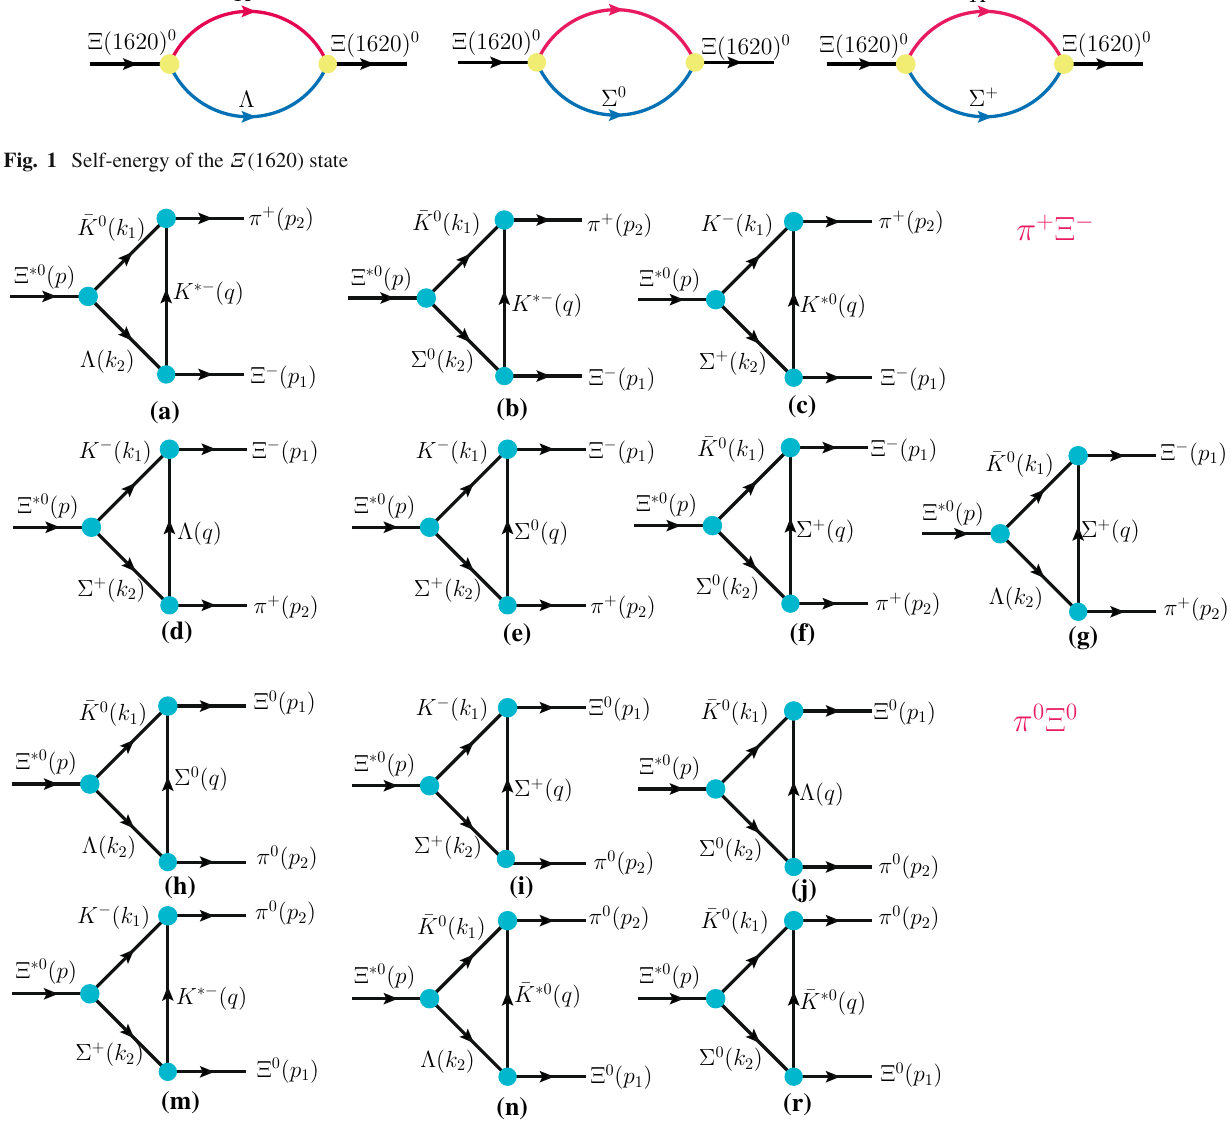
Fig. 2 Feynman diagrams for the Ξ ∗ 0 → π + Ξ − (top) and π 0 Ξ 0 (below) decay processes. We also show the definitions of the kinematics ( p , k 1 , k 2 , p 1 , p 2 , and q ) used in the calculation